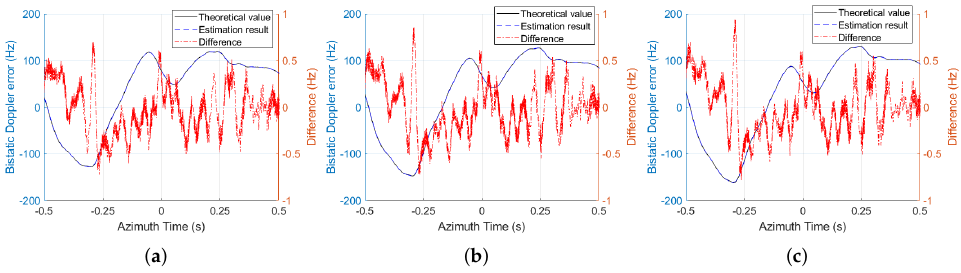
Figure 9. Doppler error estimation results of proposed method: ( a ) point A; ( b ) point B; ( c ) point